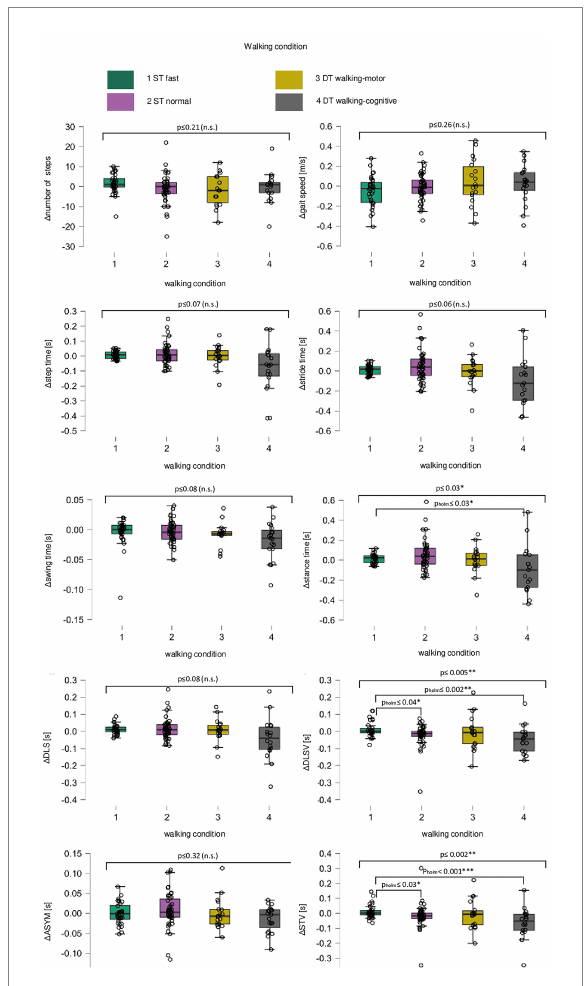
FIGURE 1 Box plots for change in all walking parameters over all walking conditions. For the change (delta of measurement point T1 minus measurement point T2, Δ ) in number of steps, gait speed (meters per second, m/s), step time (seconds, s), stride time (s), swing time (s), stance time (s), double limb support (DLS, s), double limb support variability (DLSV, s), asymmetry (ASYM, s) and step time variability (STV, s), single subject data points (black circles) are given for walking conditions single task fast pace (green, 1), single task normal pace (violet, 2), the dual task walking-motor (yellow, 3) and the dual task walking-cognitive (grey, 4). Between the four walking conditions, differences in the change in walking performance are shown [long black square brackets, using Kruskal–Wallis H-Test, significant differences are marked